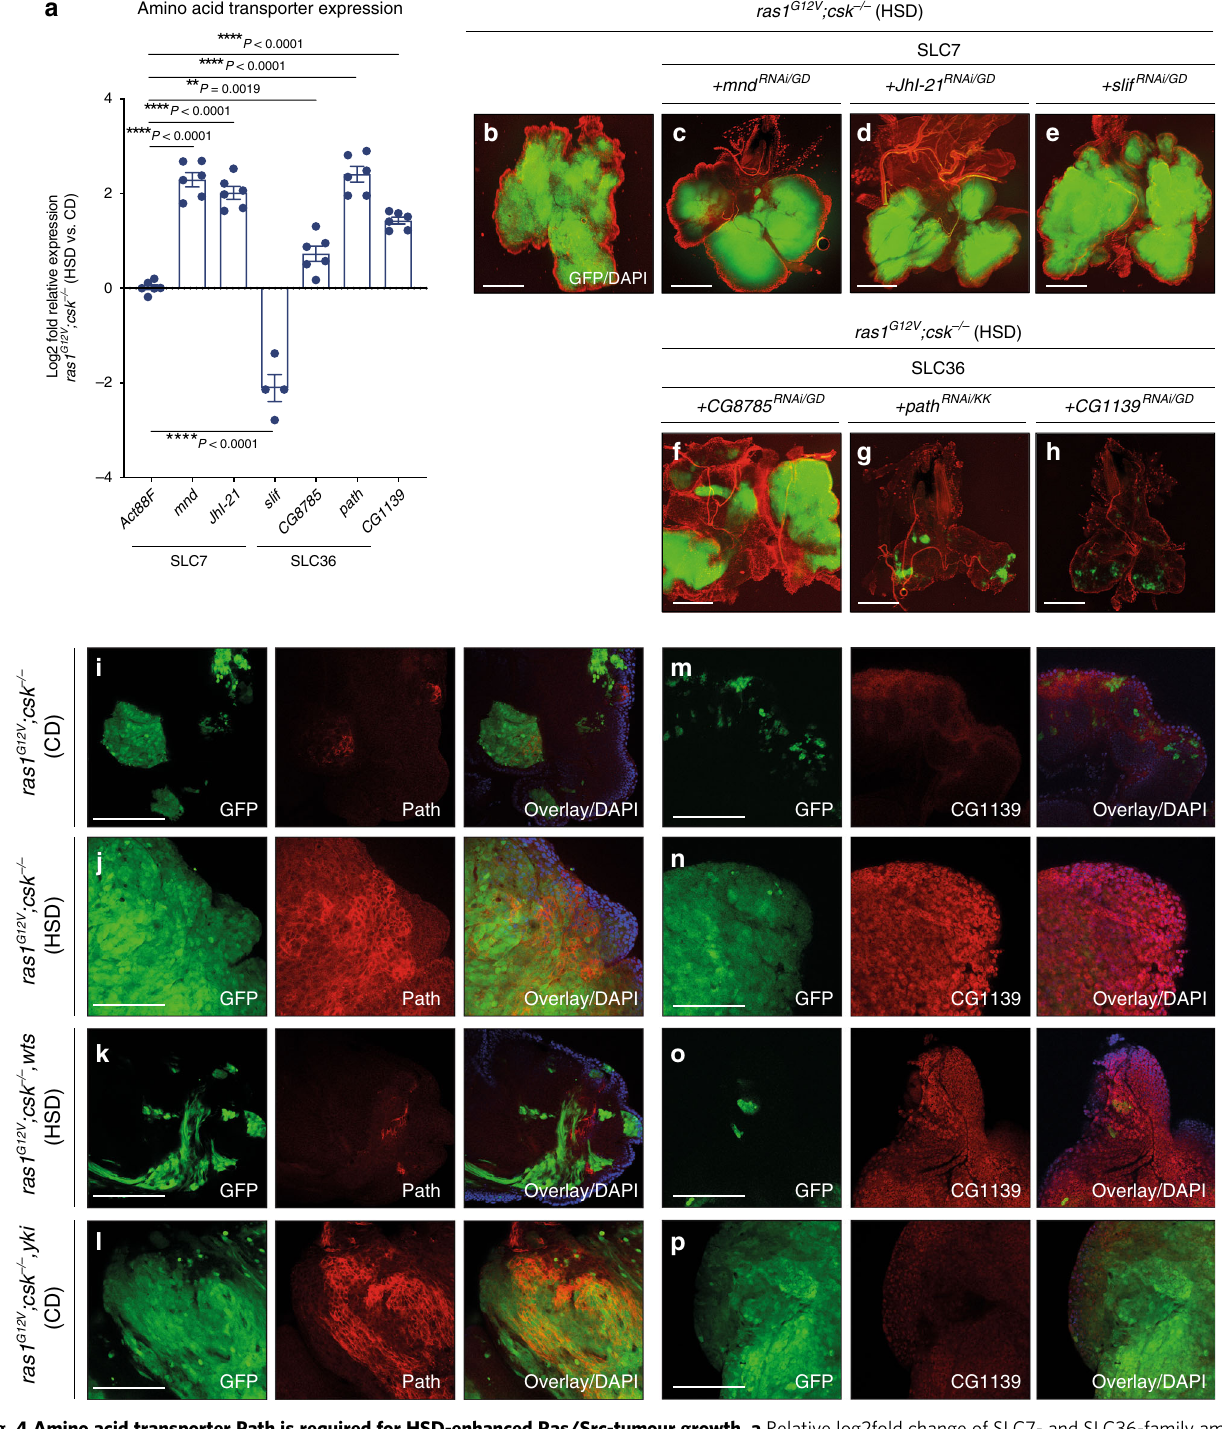
Fig. 4 Amino acid transporter Path is required for HSD-enhanced Ras/Src-tumour growth. a Relative log2fold change of SLC7- and SLC36-family amino acid transporters in dissected tumour tissue from ras1 G12V ;csk − / − animals raised on HSD compared to animals raised on CD, as determined by qPCR. Samples are normalised to Act88F . Results are shown as mean ± SEM. Data from n = 6 ( Act88F ), n = 6 ( mnd ), n = 6 ( JhI-21 ), n = 4 ( slif ), n = 6 ( CG8785 ), n = 6 ( path ) and n = 6 ( CG1139 ) biologically independent samples. Data were analysed by two-tailed unpaired Student ’ s t test. Asterisks indicate statistically signi fi cant difference (** P < 0.01; **** P < 0.0001). Dissected eye epithelial tissue stained with DAPI (red) from ras1 G12V ;csk − / − animals raised on HSD ( b ), with mnd RNAi/GD ( c ) , JhI-21 RNAi/GD ( d ) , slif RNAi /GD ( e ) , CG8785 RNAi/GD ( f ) , path RNAi/KK ( g ) and CG1139 RNAi/GD ( h ). Scale bar, 250 μ m. Anti-Path staining (red) of dissected tumour tissue from ras1 G12V ;csk − / − animals raised on CD ( i ), ras1 G12V ;csk − / − animals raised on HSD ( j ), ras1 G12V ;csk − / − ,wts animals raised on HSD ( k ) and ras1 G12V ;csk − / − ,yki animals raised on CD ( l ) with DAPI (blue). Scale bar, 100 μ m. Anti-CG1139 staining (red) of dissected tumour tissue from ras1 G12V ;csk − / − animals raised on CD ( m ), ras1 G12V ;csk − / − animals raised on HSD ( n ) and ras1 G12V ;csk − / − ,wts animals raised on HSD ( o ), and ras1 G12V ;csk − / − ,yki animals raised on CD ( p ) with DAPI (blue). Scale bar, 100 μ